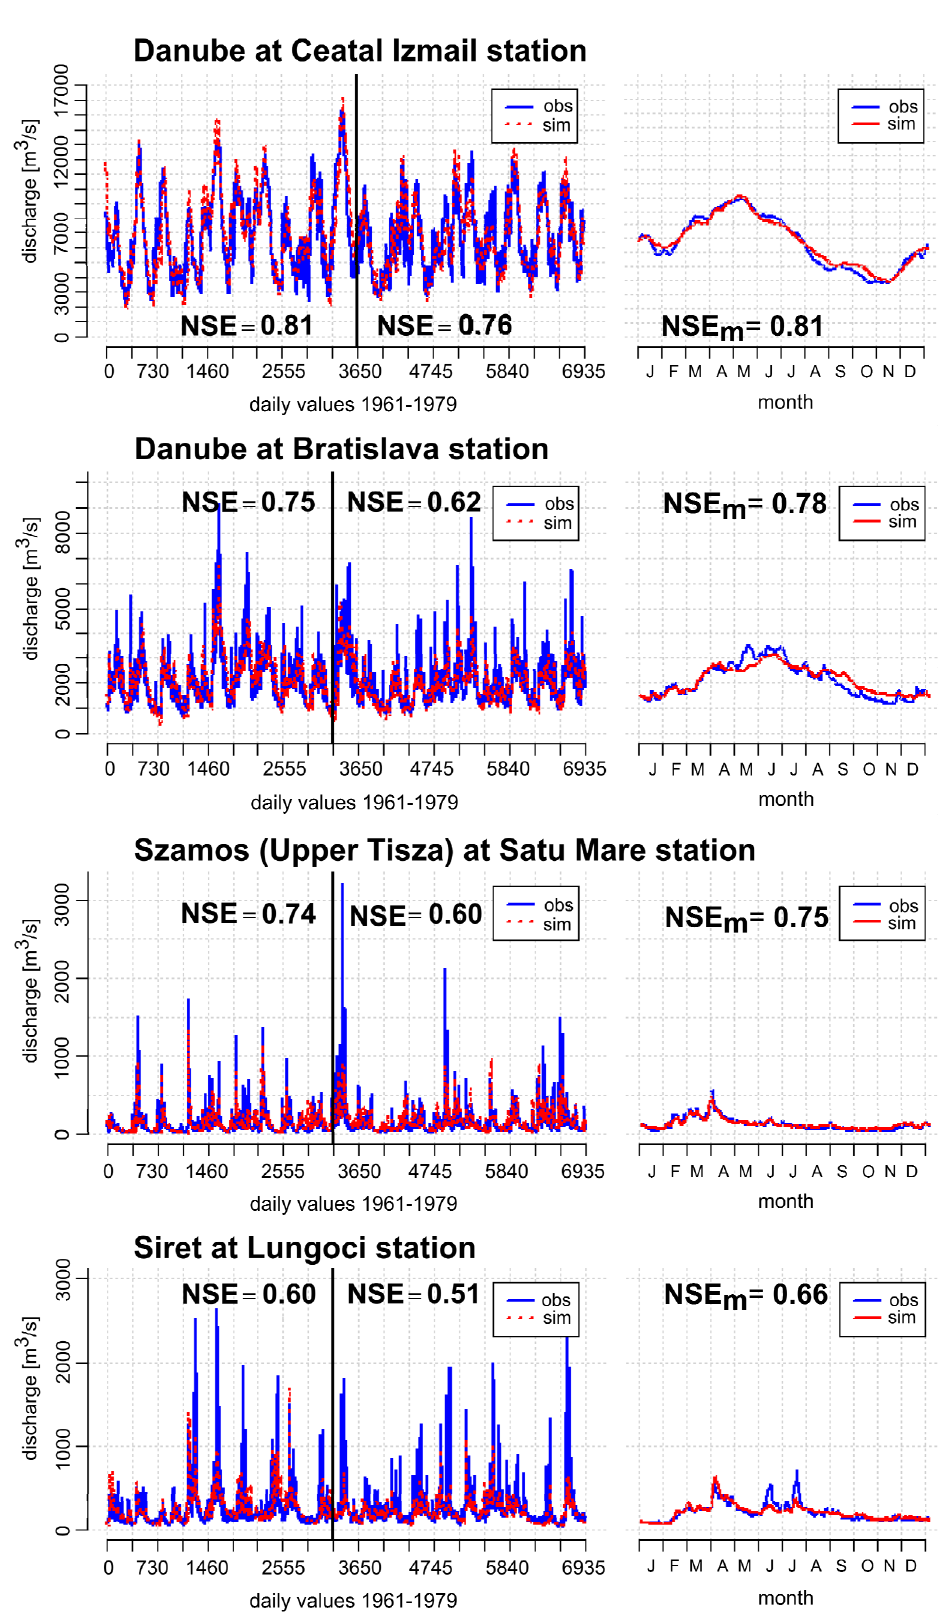
Figure 8. Results of calibration and validation for selected gauging stations under historic conditions (NSE (daily NSE), NSE m (monthly NSE), obs (observed), sim (modeled)). Left : results of calibration (first 9 years) and validation (last 11 years); right : 10-year seasonal